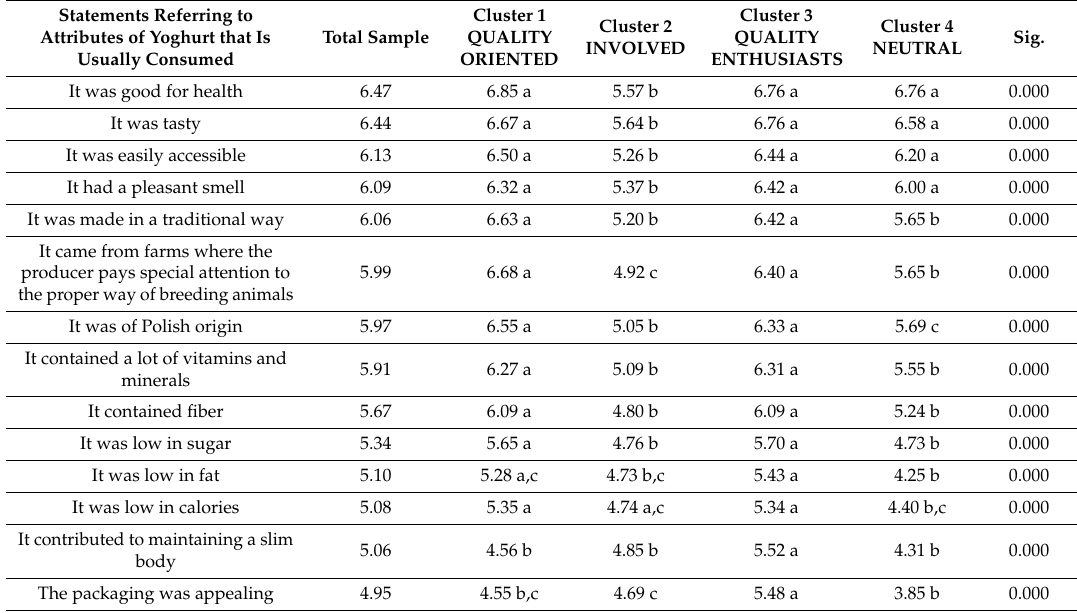
Table 5. Clusters’ profile on attitudinal questionnaire referring to the importance of some attributes of yoghurt ( N =